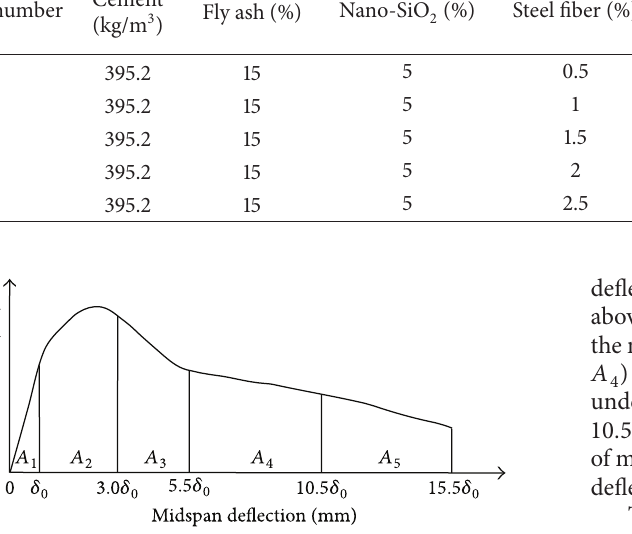
Figure 3: Calculation diagram for flexural toughness of ASTM